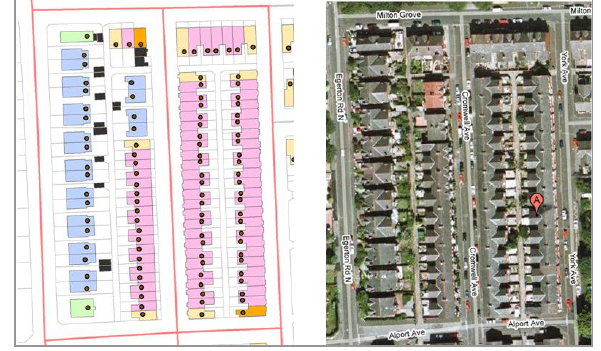
Figure 5. An example for filed